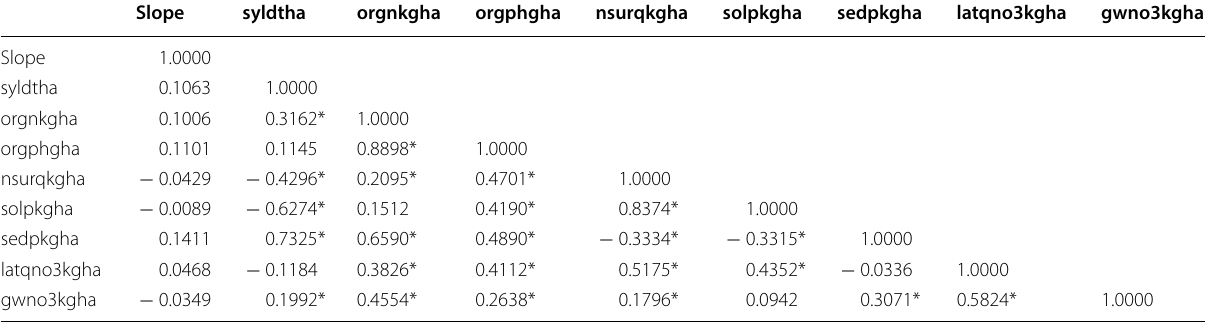
* indicates the parameters have stastically significant relationship at p